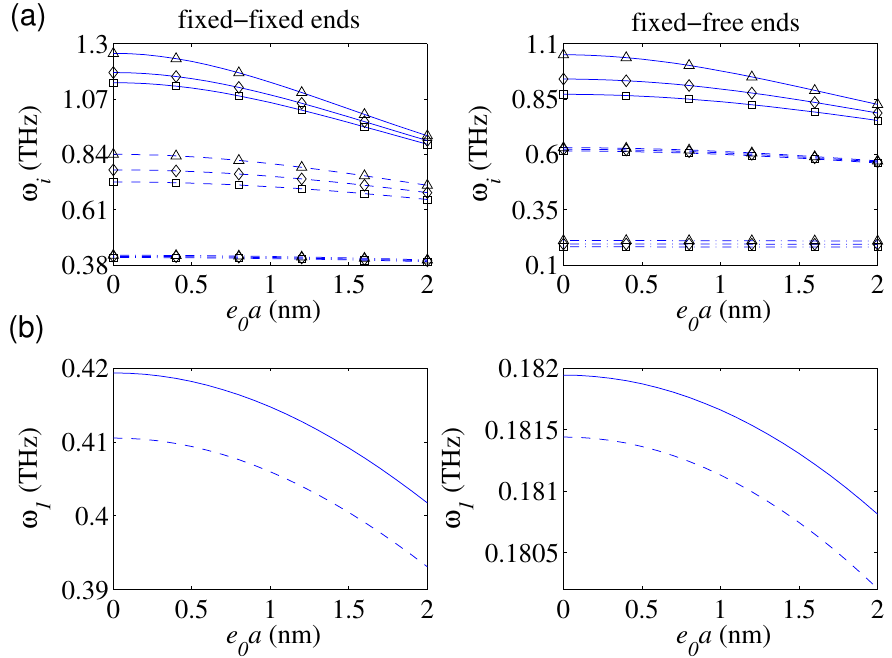
Figure 2. The first three frequencies as a function of e 0 a for: ( a ) different defect parameters: ( χ 2 c 1 = 8 nm; ( − . − ) ω 1 , ( −− ) ω 2 , (—) ω 3 ; ( (cid:3) ) ¯ k 1 = 4, ( ♦ ) ¯ k 1 = 8, ( (cid:52) ) ¯ k 1 = 10,000), ( b ) both nonlocal elasticity theory (NET)-based and nonlocal surface elasticity theory (NSET)-based models; ( l b = 20 nm, D 0 = 0.5 nm, c 1 = 8 nm, ¯ k 1 = 4, N = 1, ¯ H y = ¯ H z = 0.1; ( −− ) NET, (—)